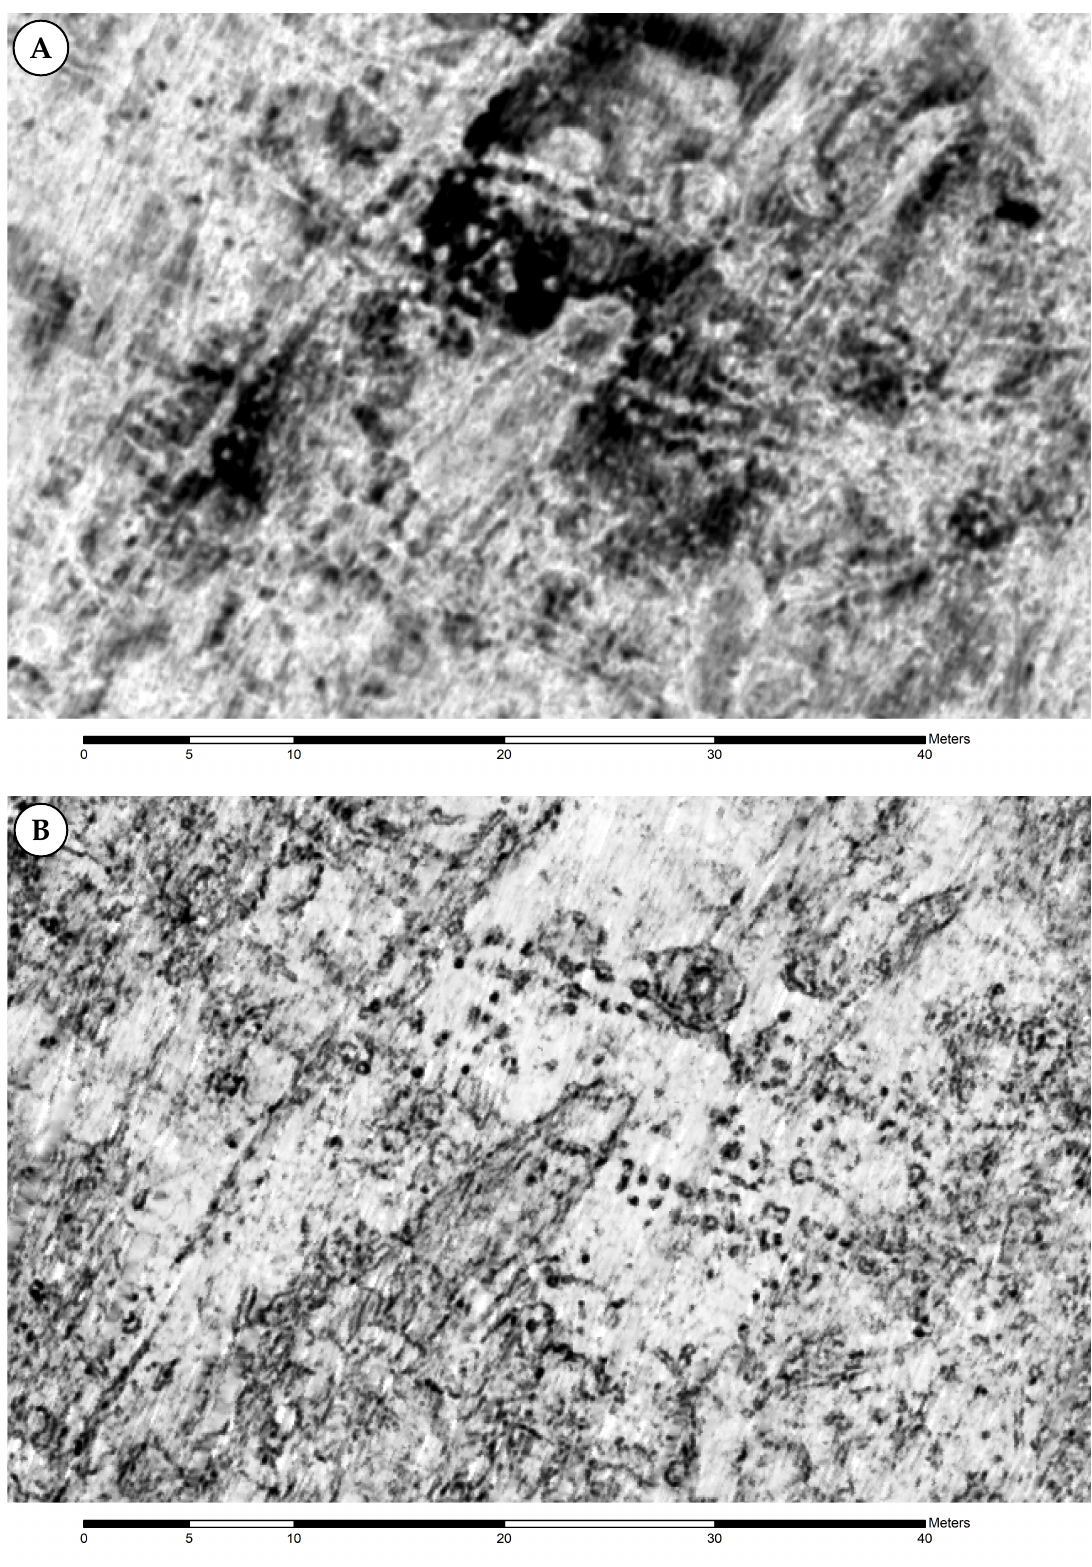
Figure 6. Stadil Mølleby (detail): Migrated GPR depth-slices from 55–85 cm depth showing the same area. ( A ) Conventional reflection amplitude map. ( B ) Inline coherence image. Note the rows of pits indicating building remains clearly visible in the coherence